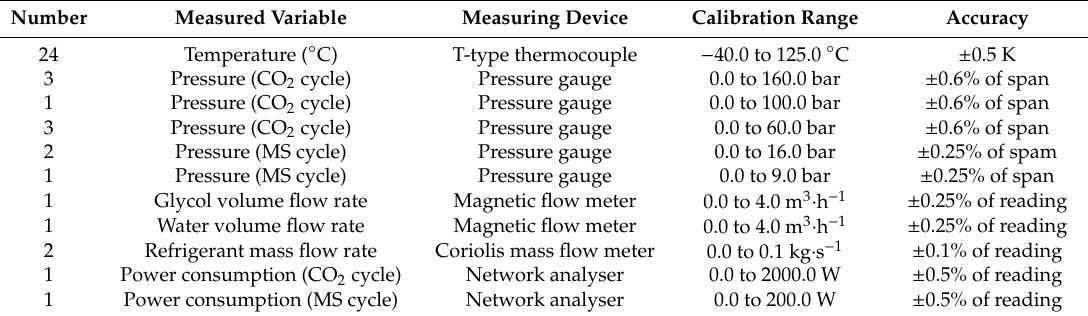
Table 1. Accuracies and calibration range of the measurement devices.